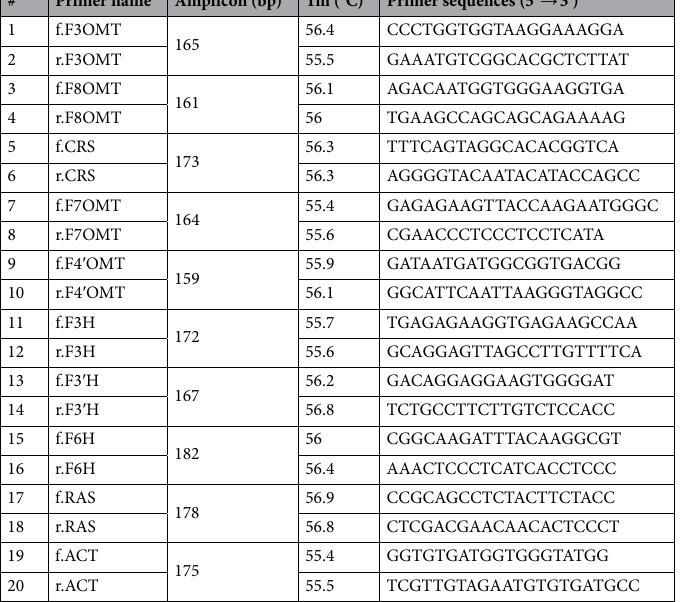
Table 1. Isoform-specific primers used for